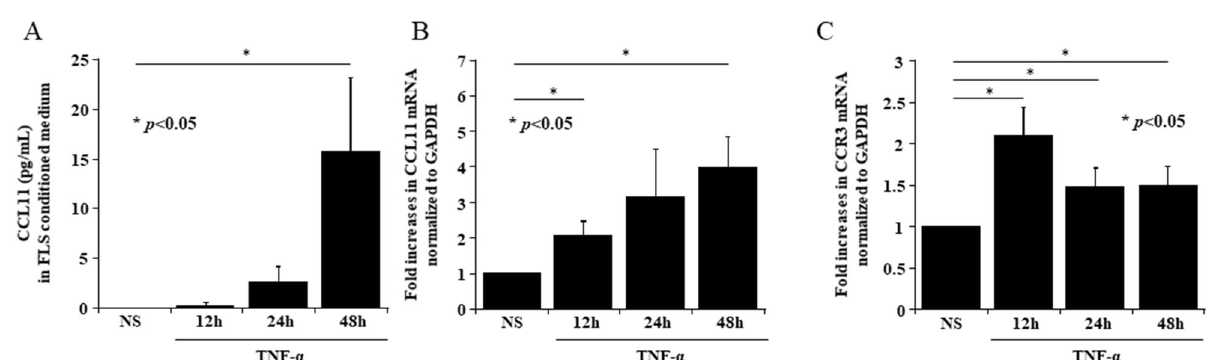
Figure 3. TNF-α stimulation increased the expression of CCL11 and CCR3 in RA FLS. ( A ) The secretion of CCL11 in RA FLS-conditioned medium and ( B ) the expression of CCL11 mRNA were increased by 50 ng/mL TNF-α stimulation in a time-dependent manner at 12, 24 and 48 h (n = 7 patients). ( C ) The peak expression of CCR3 mRNA induced by 50 ng/mL TNF-α stimulation was at 12 h (n = 7 patients). NS no stimulation. The data values are expressed as the mean ± SEM. * p < 0.05 was